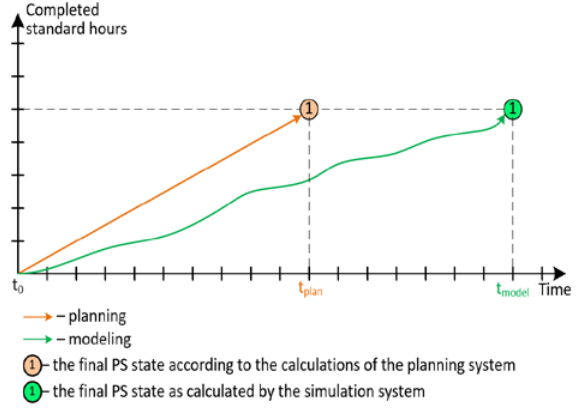
Fig. 2. Graphs of changes in the planned and simulated state